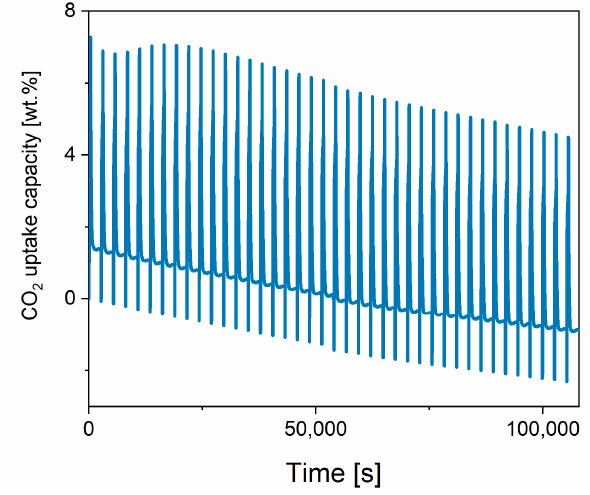
Figure 5. Cyclic stability of K-B after 40 cycles (with both the CO 2 uptake at 800 ◦ C and regeneration at 900 ◦ C, cycles set at 6 min each, CO 2 flow 50 mL/min). Table 3. Performance of K-B, K-C, and K-D under long exposition (with both the CO 2 uptake at 800 ◦ C and regeneration at 900 ◦ C, cycles set at 360 s each, CO 2 flow 50 mL/min). K-B Cycle 1 10 CO 2 ads., wt.% % lost Cycle 1 CO 2 ads., wt.% % lost 0 K-D Cycle 1 CO 2 ads., wt.%